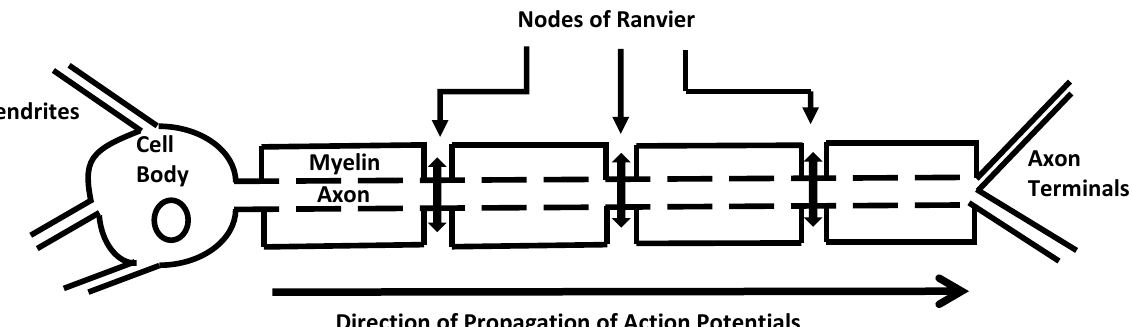
Figure 2. Schematic of a myelinated neuron: the information travels from the cell body to the terminal through the axon made of myelinated regions separated by the nodes of Ranvier. The information is transmitted through action potentials which happen only at the nodes of Ranvier and are represented by vertical double arrows. Here we consider neurons which do not have backpropagating action potentials, and thus the only direction of propagation of the action potentials is from the cell body to the axon